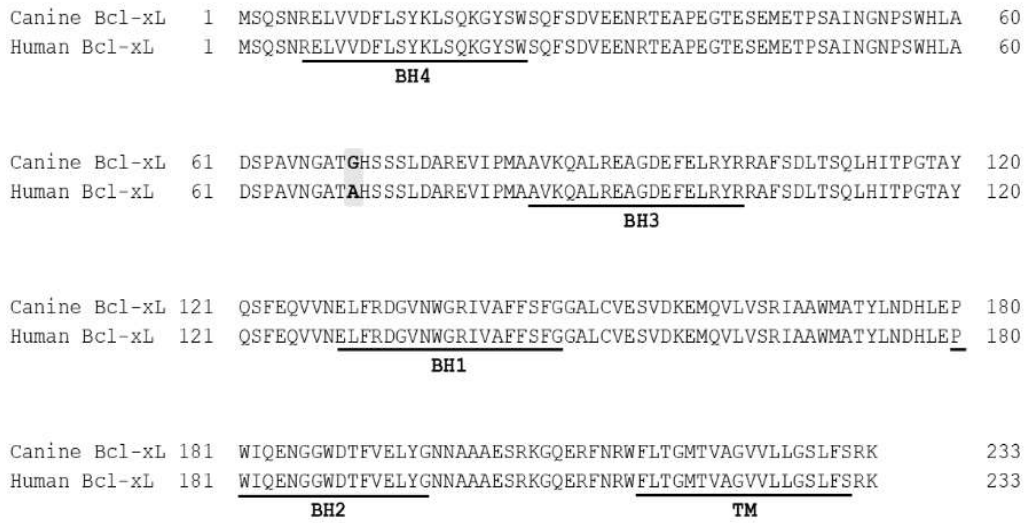
Figure 1. Amino acids sequences alignment of canine and human Bcl-xL after Sano J 2003. The sequences of Bcl-2 homology domains (BH 1-4) and transmembrane domain (TM) are underlined. Variant residues are highlighted in bold and gray background.